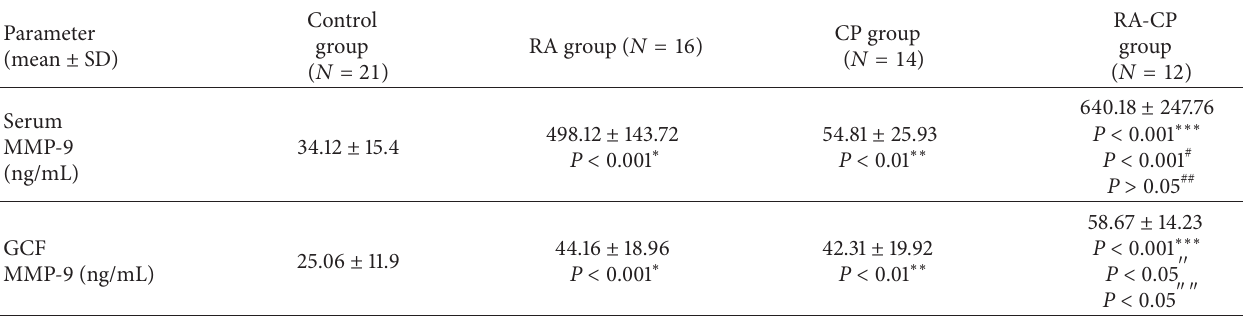
Table 2: MMP-9 levels of crevicular and serum concentrations in RA, RA-CP, CP, and healthy groups and statistical significance comparison between